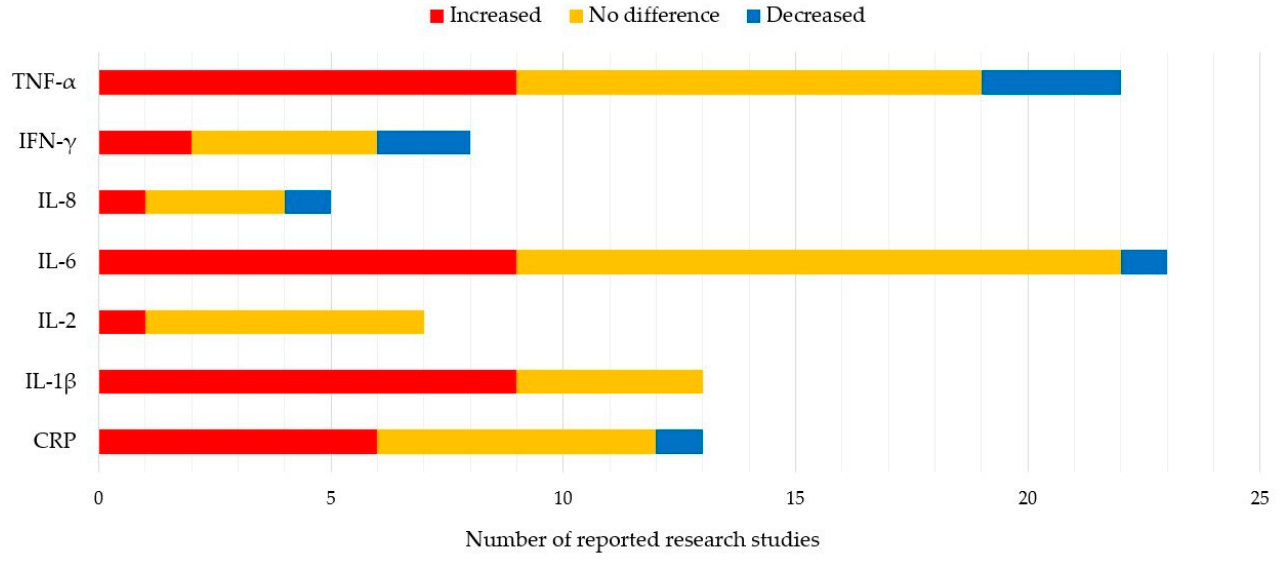
Figure 1. 7 Most reported blood biomarkers and their value relative to healthy controls.